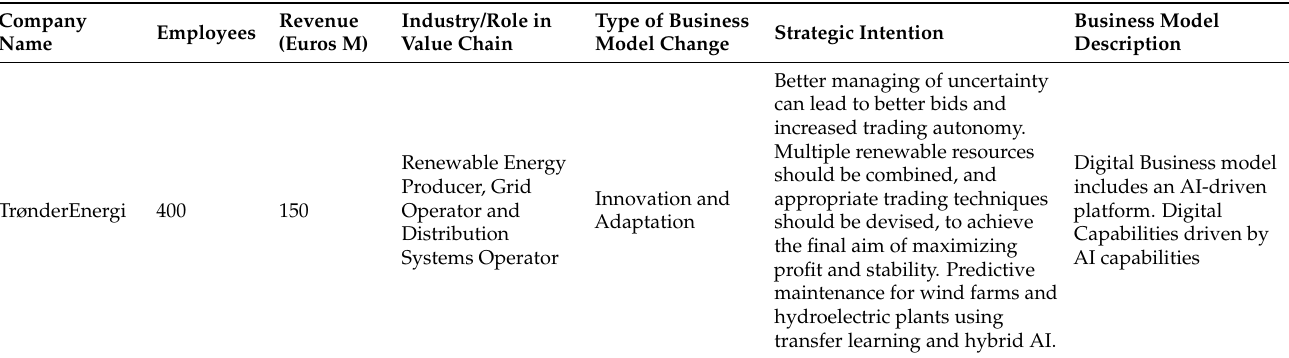
Table 1. Business Model